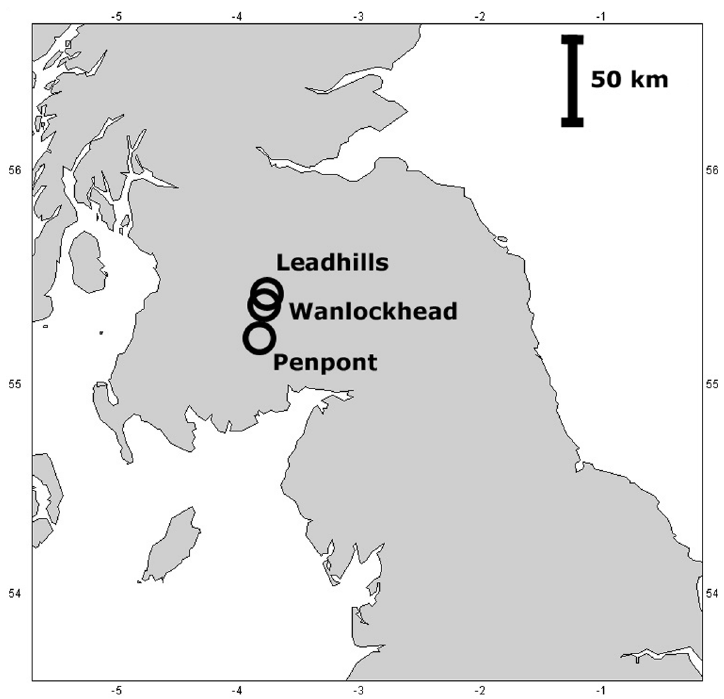
Fig. 8. Places mentioned in connection with the Leadhills earthquakes of 1746 and